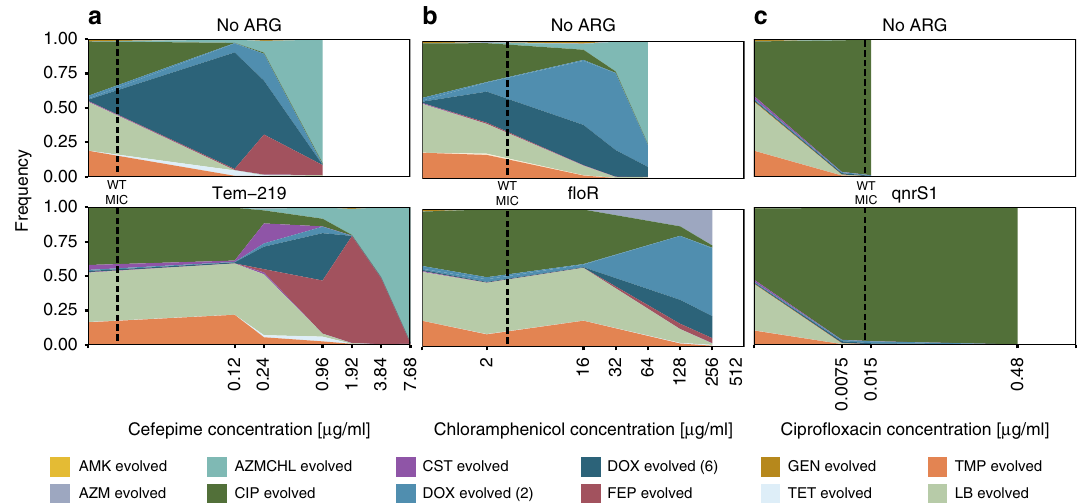
Fig. 3 Concentration-dependent mutant selection with and without ARG shielding. Mutant pools with and without expression of Tem-219 beta- lactamase ( a ) or the FloR ef fl ux pump ( b ) at different concentrations of either cefepime (Tem-219) or chloramphenicol (FloR) were sequenced to determine the mutant selection patterns. Panel c Shows the dynamics of mutant selection in the presence of the qnrS1 conferring low resistance compared with the gyrA mutation. Mutants were evolved in AMK (amikacin), AZM (azithromycin), AZMCHL (azithromycin and chloramphenicol), CIP (cipro fl oxacin), CST (colistin), DOX_2 (doxycycline — low resistance), DOX_6 (doxycycline — high resistance), FEP (cefepime), GEN (gentamycin), LB (Medium without antibiotics), TET (tetracycline), and TMP (trimethoprim). Source data are provided as a Source Data fi